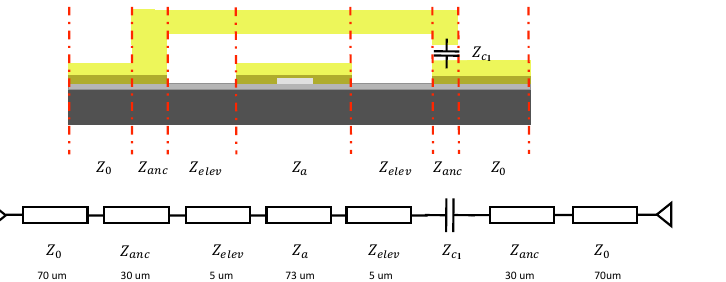
Figure 12. A comprehensive transmission line circuit model for OFF state MEMS switch.